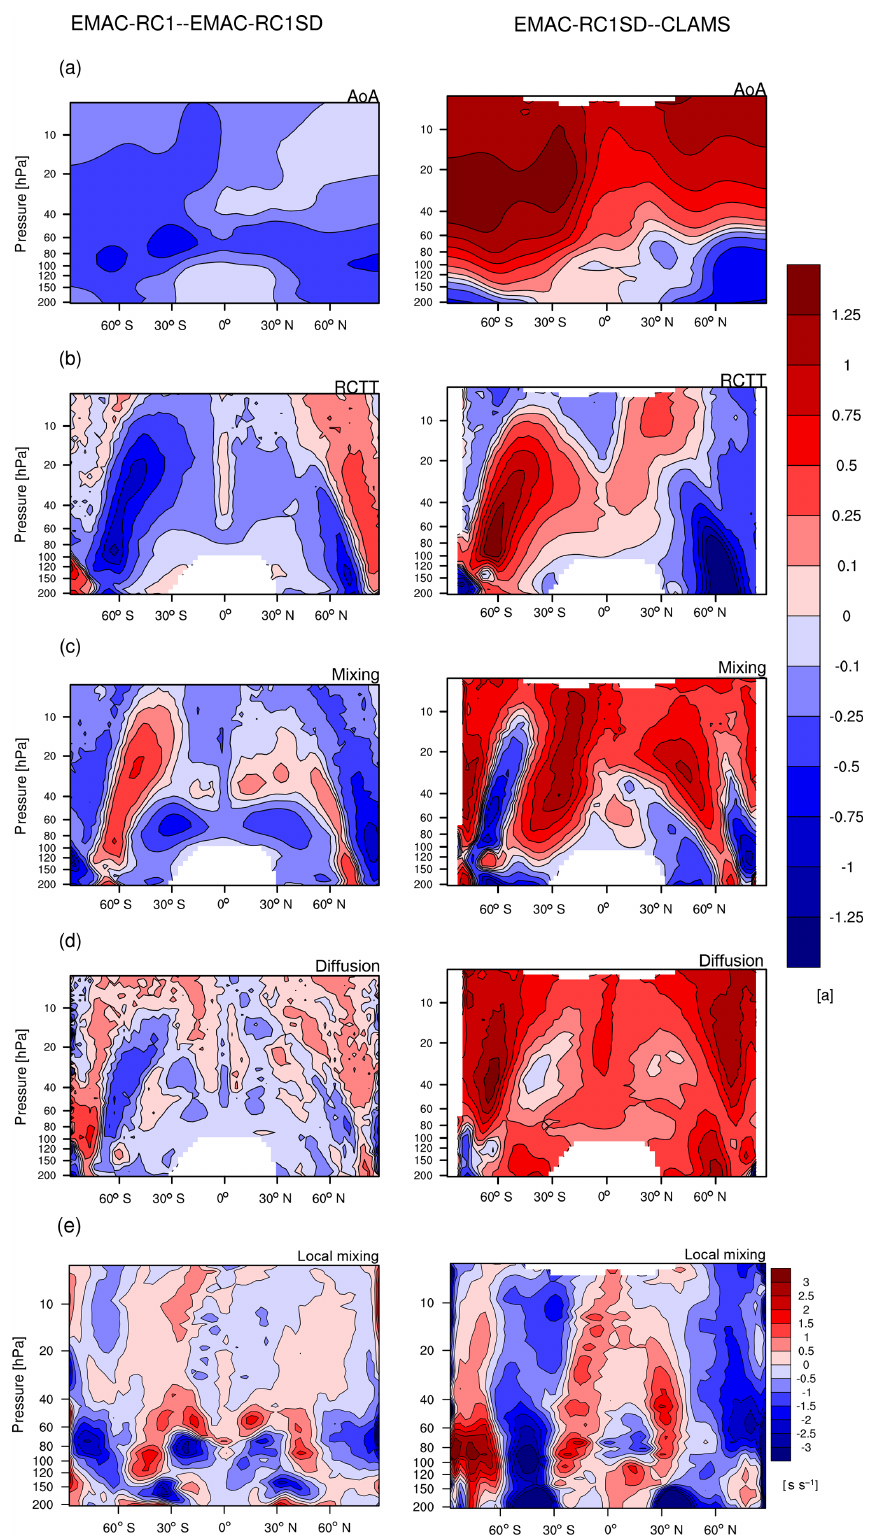
Figure 3. Zonal annual mean of the absolute differences in (a) AoA, (b) RCTT, (c) resolved aging by mixing, (d) aging by diffusion between EMAC-RC1 and EMAC-RC1SD (left), and between EMAC-RC1SD and CLaMS-ERAI (right). Moreover, the absolute differences for the local mixing tendencies are shown panel (e) . Note that the difference between EMAC-RC1SD and CLaMS-ERAI is calculated relative to the same reference